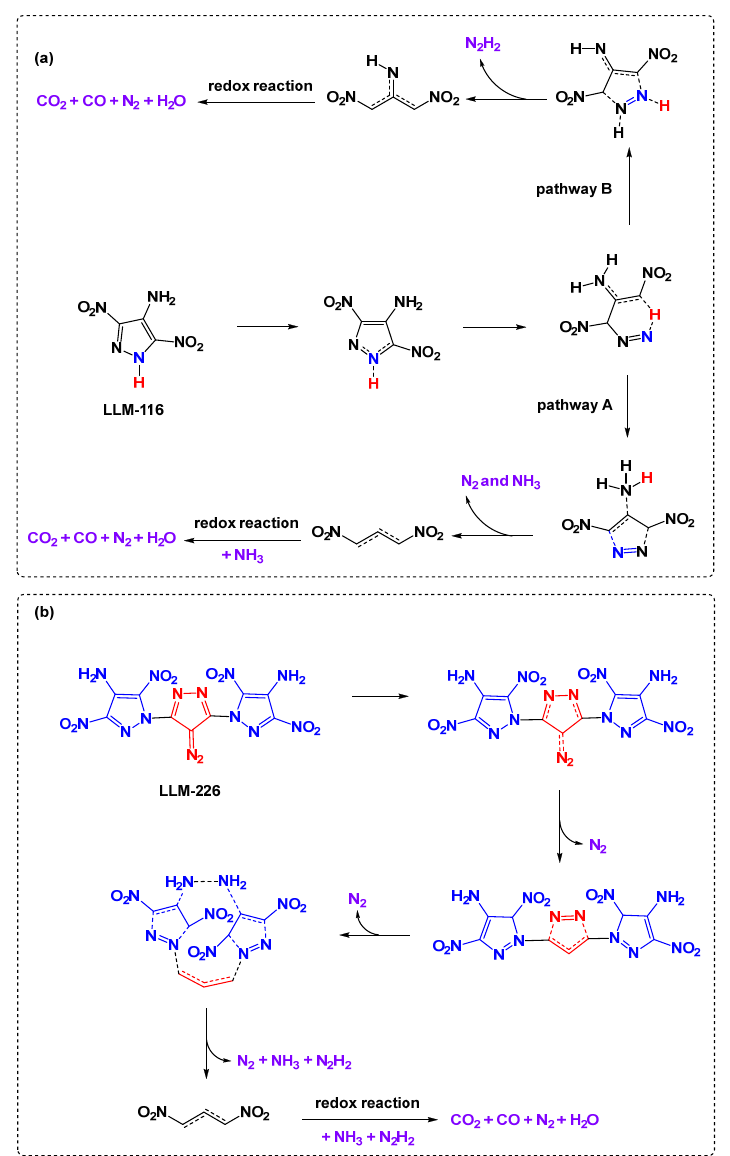
Figure 11. Proposed decomposition mechanisms of LLM-116 ( a ) and LLM-226 ( b ).